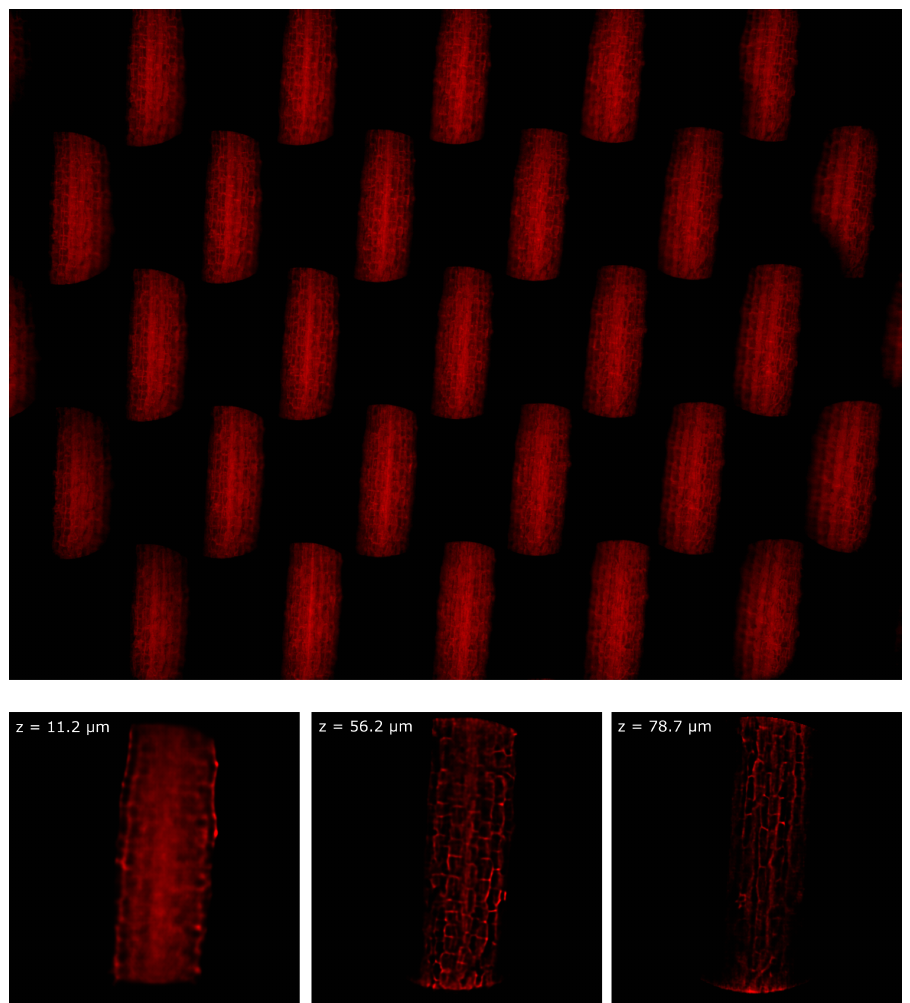
Figure 9. Hypocotyl of Arabidopsis Thaliana imaged with a water immersion objective. On the top, the entire frame registered by the device. On the bottom, the sample reconstructed at three different